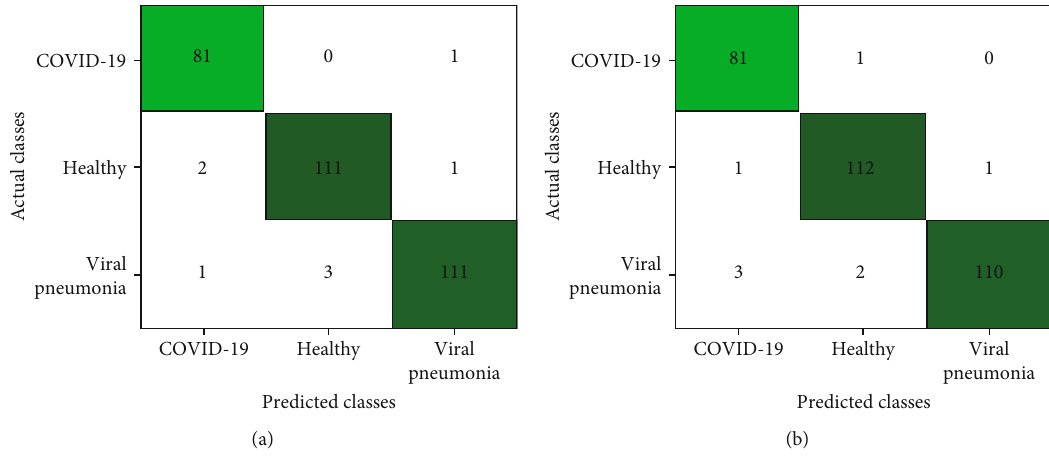
Figure 6: Confusion matrix of (a) VGG16 and (b) MobileNet. Table 5: Parameters of di ff erent CNNs for COVID-19 with the best value in bold (%).